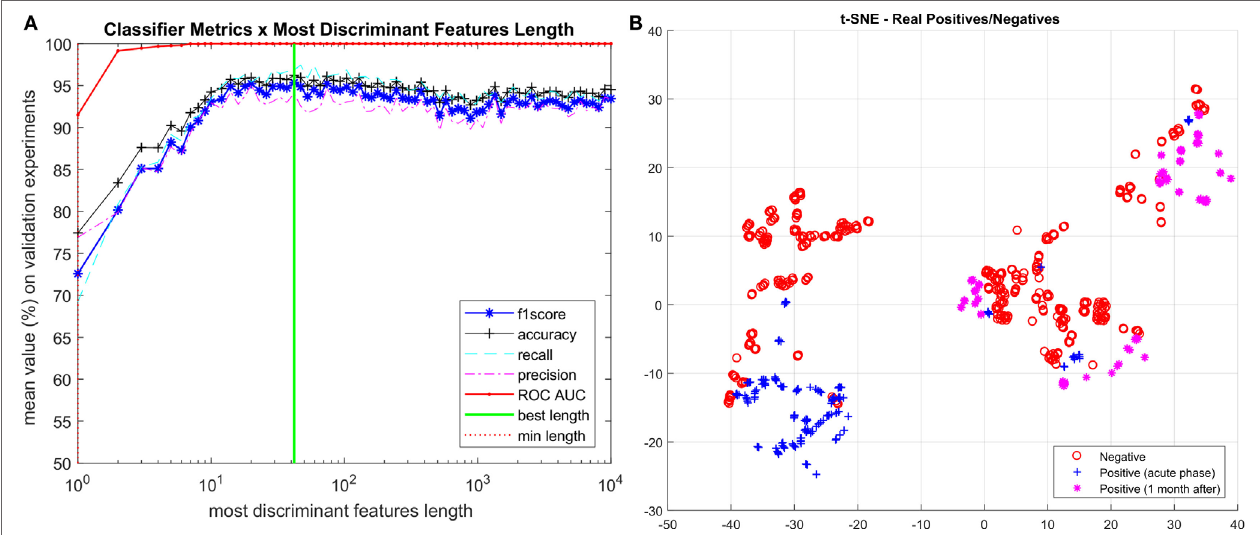
FigUre 2 | (a) Iterative process to determine the most discriminant ranked features. (B) Visualization of vectors with spectral signature features (length 42) using t-SNE technique. Vectors corresponding to positive Zika virus-infected patients are separated into two categories: acute phase and 1 month after infection.